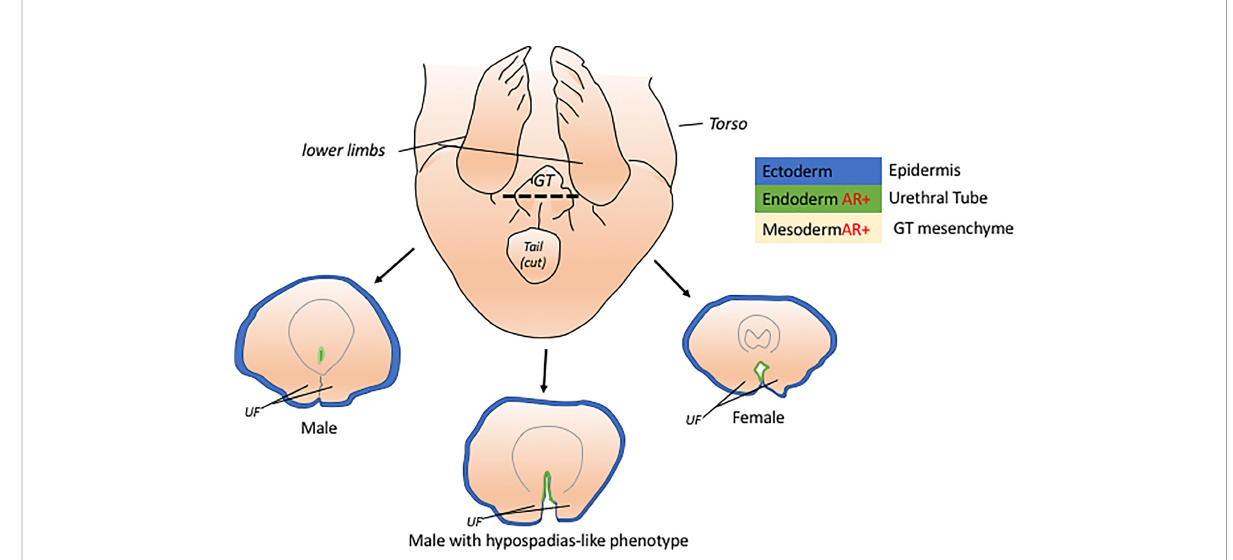
FIGURE 1 The genital tubercle or GT is the common anlage of the penis and clitoris. The GT has cells from 3 embryonic layers, ectoderm, mesoderm, and endoderm. At early embryonic stage, the male GT is distinguished from female GT through the fusion of the urethral folds (UF) which can be viewed histologically through a cross-section of the GT (dotted line). The masculinization of the male GT is attributed to the active androgen signaling in the endoderm and mesoderm tissues of the GT. Unfused UF in males, hypospadias-like phenotype, are due to disruptions in the signaling of the endoderm and mesoderm of the